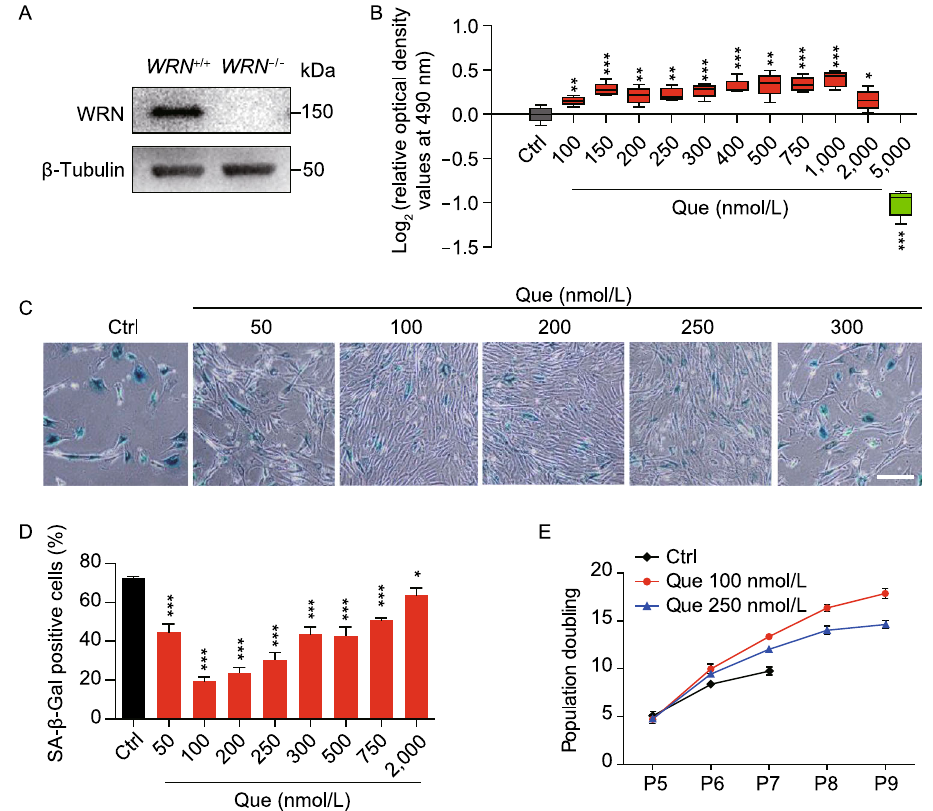
Figure 2. Identi fi cation of the optimal concentration of Que for alleviating aging and promoting proliferation of WS hMSCs. (A) Immunoblotting analysis of WRN protein in WTand WS hMSCs (passage 5). β -Tubulin was used as the loading control. (B) MTS assay of WS hMSCs (passage 5) after 7-day treatment of Que at a series of concentrations ( n = 5). * P < 0.05 vs. Ctrl; ** P < 0.01 vs. Ctrl; *** P < 0.001 vs. Ctrl. (C) Analysis of SA- β -Gal activity in vehicle- (Ctrl) and Que-treated WS hMSCs (passage 7). Representative images of SA- β -Gal staining. Scale bar, 100 μ m. (D) Frequency of SA- β -Gal positive cells ( n = 3). * P < 0.05 vs. Ctrl; *** P < 0.001 vs. Ctrl. (E) Accumulative growth curve showing the population doubling of vehicle- and Que-treated hMSCs ( n =